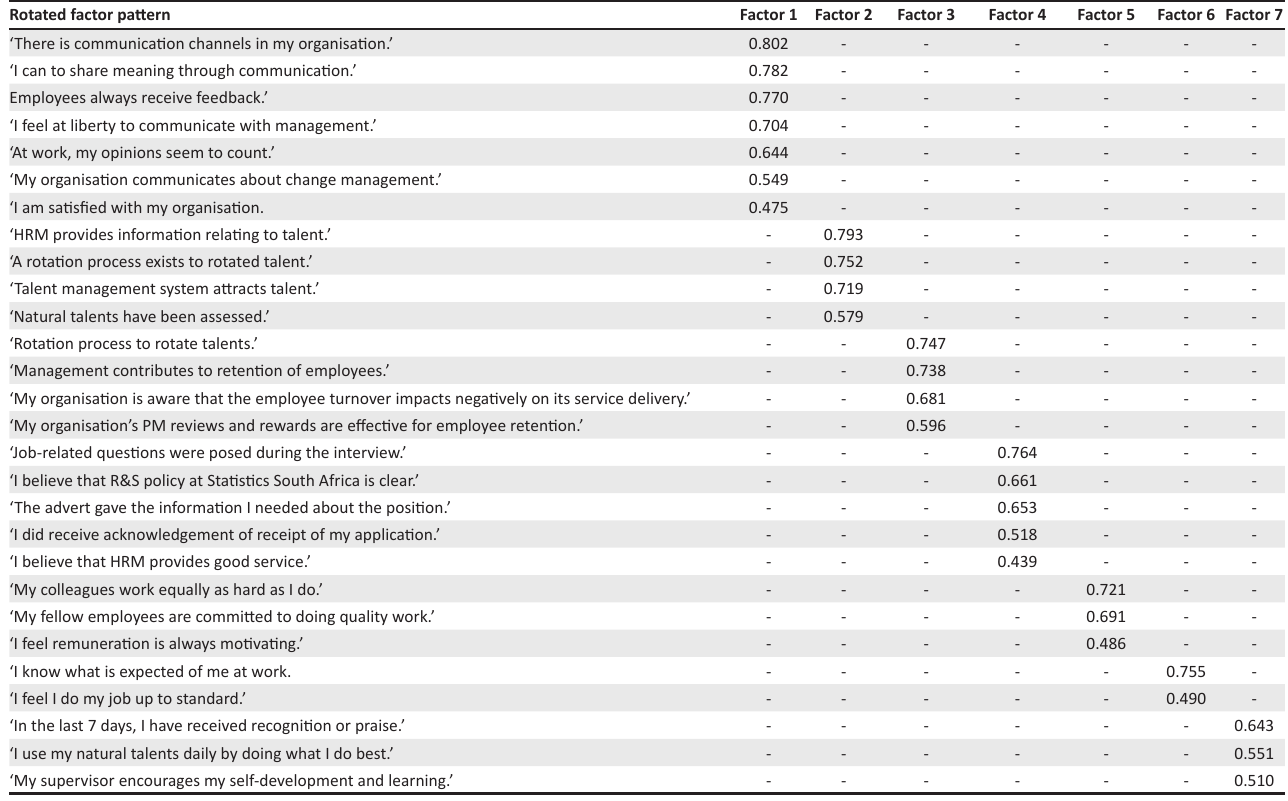
TABLE 1: Rotated factor pattern of the factor analysis. Rotated factor